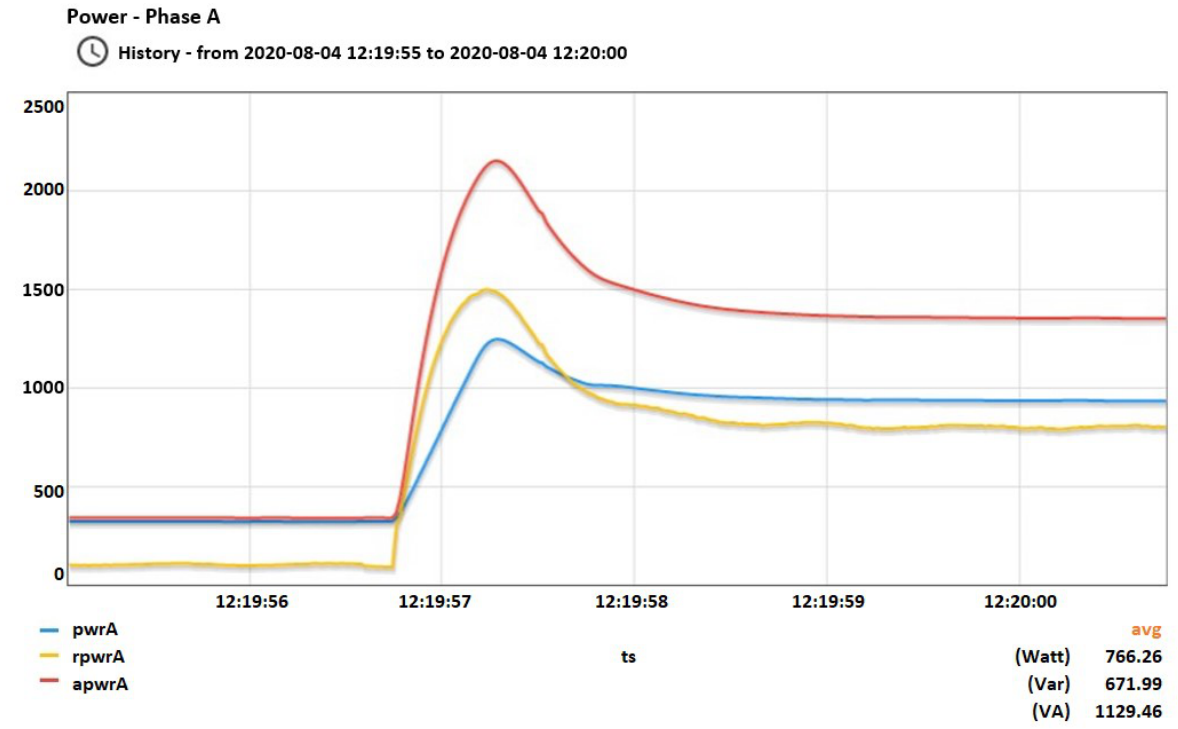
Figure 9. A snapshot from vacuum’s